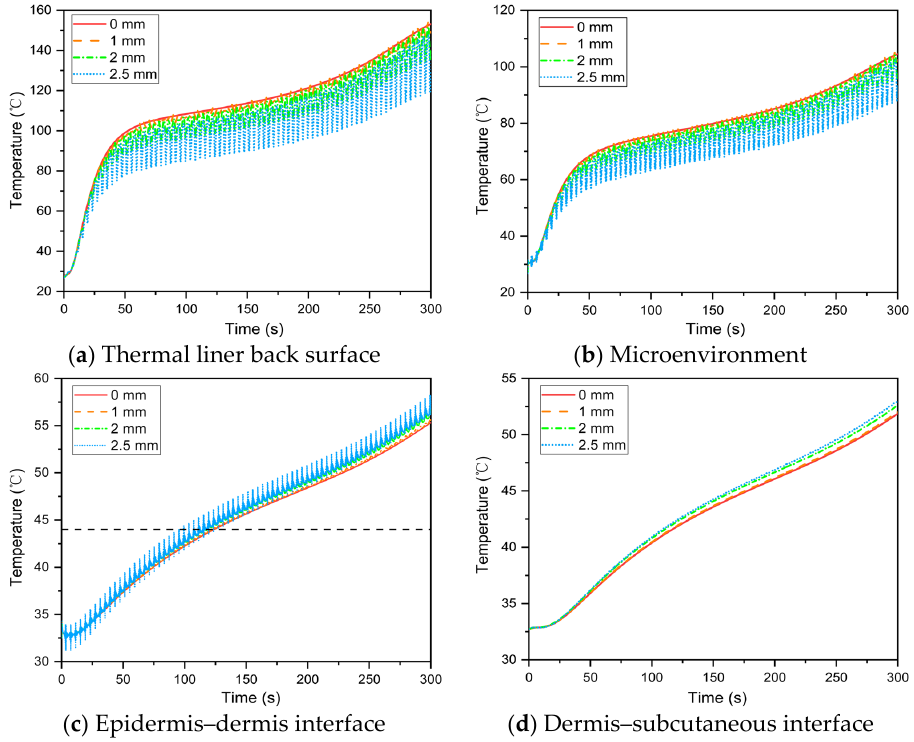
Figure 10. Effect of the fabric movement amplitude on radiative, conductive and total heat fluxes through the microenvironment between the thermal liner back surface and the skin.